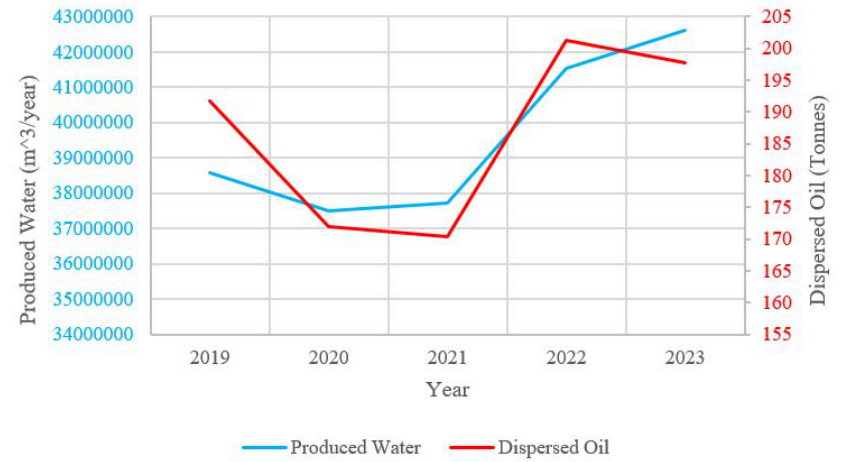
Figure 2. Produced water and discharged dispersed oil from the Danish platforms in the North Sea. The platforms include: Dan, Gorm, Halfdan, Tyra, Syd Arne and Siri. The fields are operated by Total E&P Danmark A/S, Hess Danmark ApS and INEOS Oil & Gas. The blue graph illustrates the total amount of produced water from the fields. The red graph illustrates the discharged dispersed oil in the